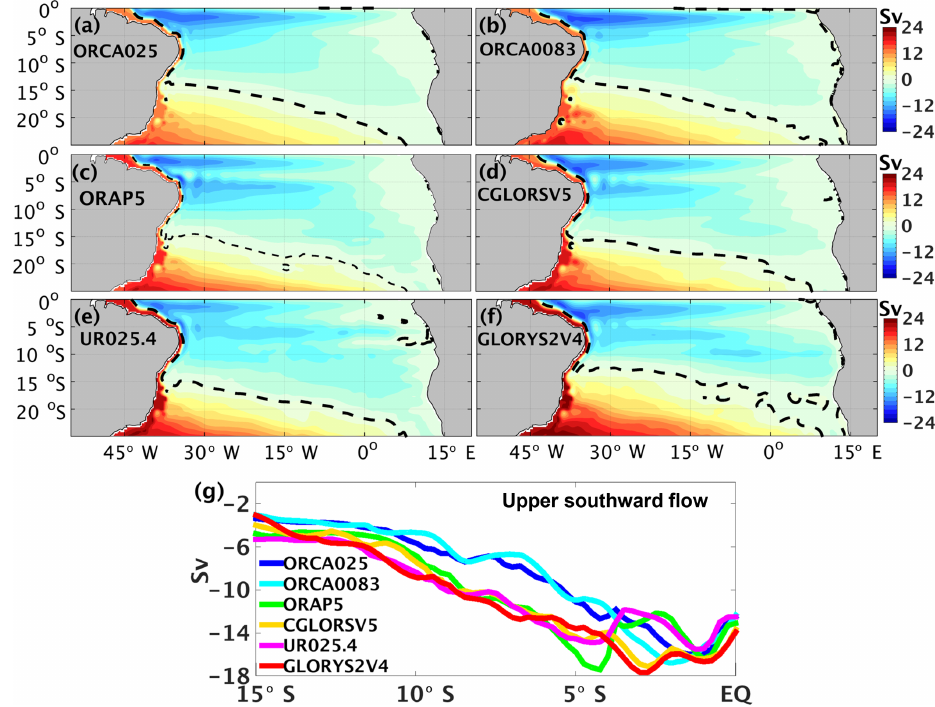
Figure 4. East–west accumulated volume transports (1997–2010) for each product (a–f) calculated from the surface down to z max at each latitude. The upper southward flow in (g) is defined by the southward maximum of the east–west accumulated volume transports. Units are inSv and the black dashed contour corresponds to 0Sv.